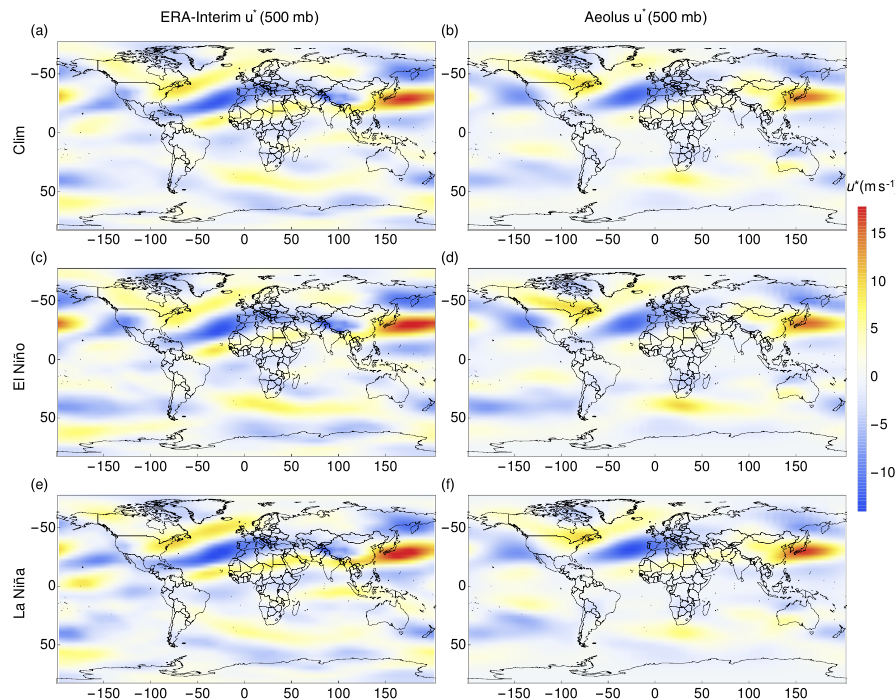
Figure 1. Azonal large-scale zonal wind u ∗ at 500mb for all February months/El Niño February months/La Niña February months. The left column shows the results from reanalysis data and the right column shows the results from Aeolus received by optimized parameters. The model is forced by surface temperature, humidity and cumulus cloud fraction.